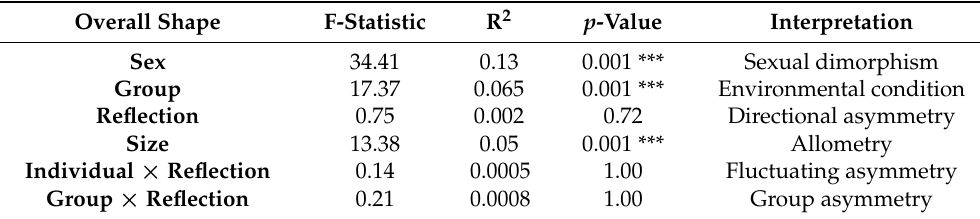
Table 5. Results of the Procrustes ANOVA between the dependent variable of shape and the independent variables of “individual”, “reflection”, “group” (wild and captive), “sex”, “size” and the joint effect of “individual per reflection” and “individual per group”. Asterisks indicate